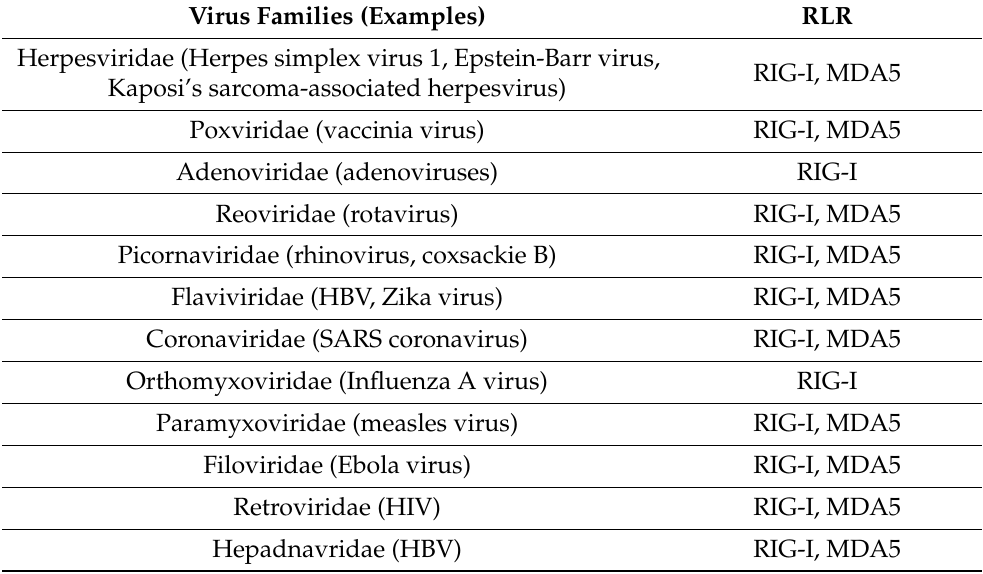
Table 3. Receptor ligands for